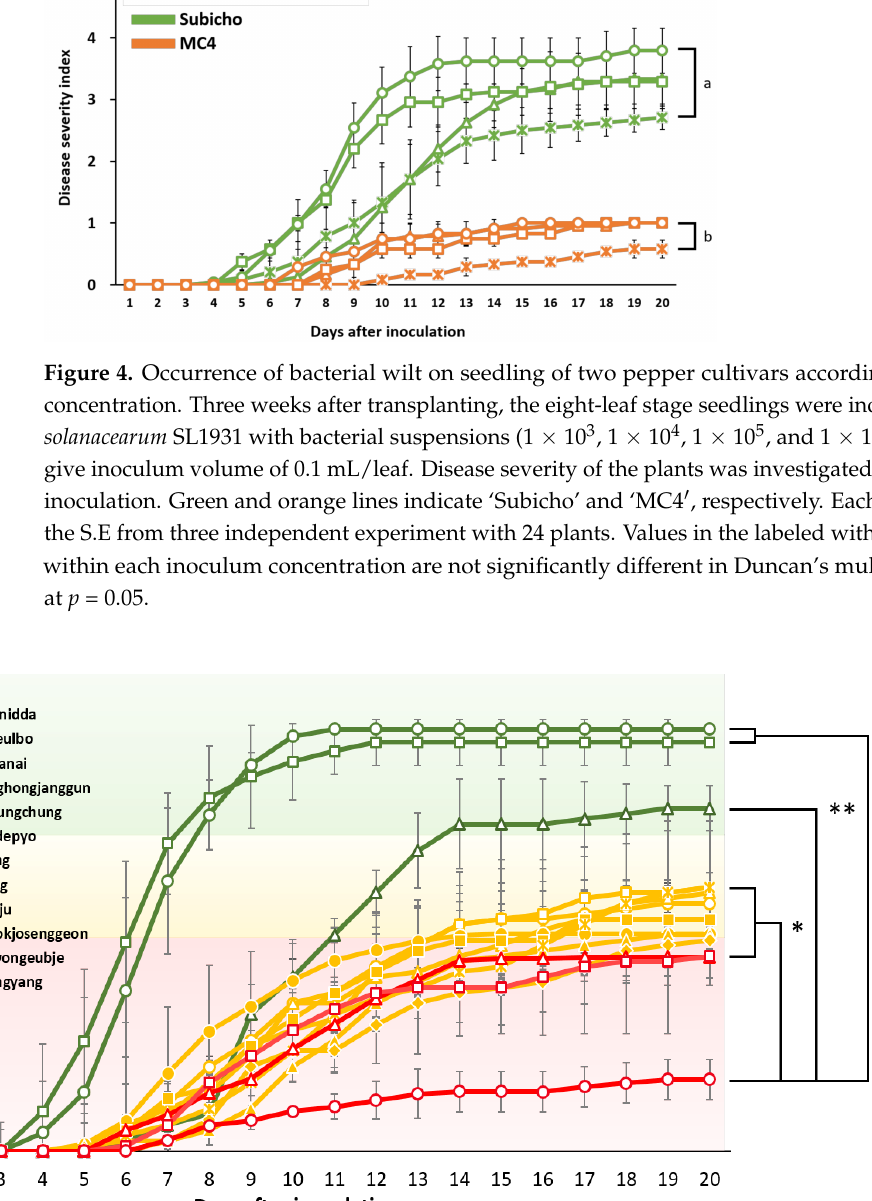
S e a Disease severity index (DSI) was represented by a 0 to 4 rating scale. b The AUDPC was calculated based on DSI scores evaluated at 0, 7, 10, and 15 days after inoculation (dai). c Relative (r) AUDPC (%) of each cultivar to AUDPC of the ‘Suppermanidda’ that is most the susceptible cultivar. d DSI of < 2 is considered resistant, 2 ≤ DSI < 3 is moderately resistant and susceptible was defined with DSI of ≥ 3. Each data point represents the mean DSI from three independent experiments. A total of 30 plants were analyzed for each cultivar. e Root-cut drench method by Hwang et al. (2017). f Root-dipping method by Lee et al. (2018). g Each value represents the mean disease index of values in the labeled with the same letter with each column are not significantly different in Duncan’s multiple range test at p < 0.05. Furthermore, on the LWB method, we compared the BW phenotype with the previous root and soil inoculation methods (Table 1). We also calculated the area under